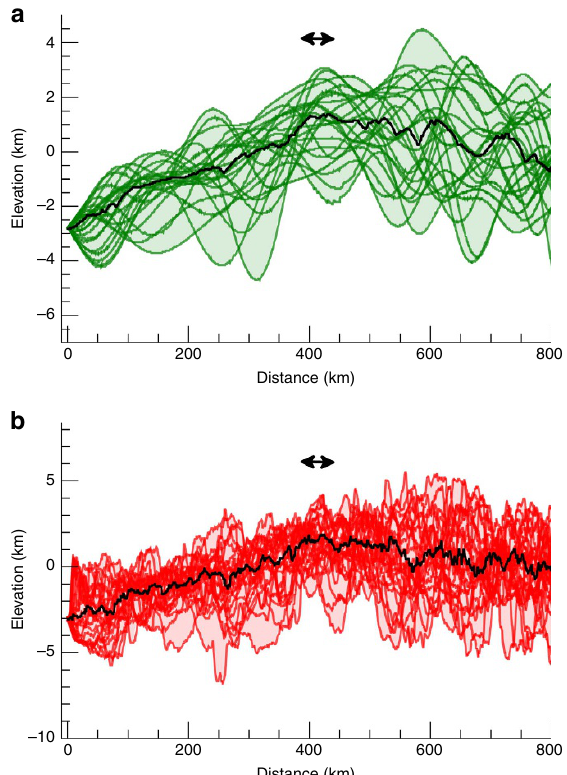
Figure 4 | Topographic profiles for Vendimia Planitia. ( a , b ) Filtered and real topography, respectively. Black lines are the median of the profiles. Elevations are computed with respect to the 482 (cid:3) 482 (cid:3) 446km ellipsoid 7,16 . Distance is computed along the surface of the best ellipsoid. Topographic profiles are for increments of 15 (cid:2) in azimuth, starting from the center of the feature (133 (cid:2) , 21 (cid:2) N) (see Fig. 3). Black arrows indicated the position of the rims.